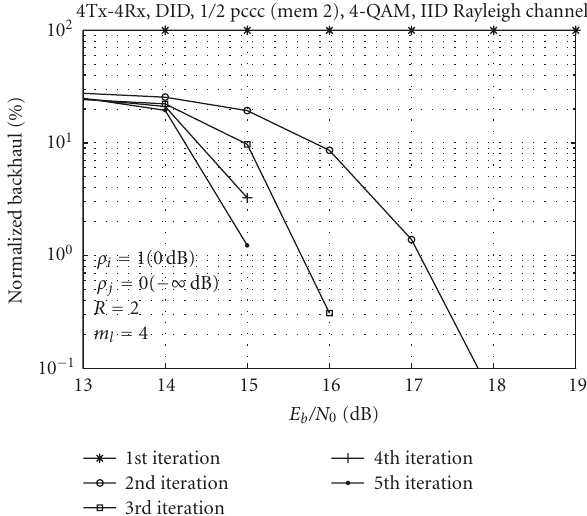
Figure 14: Backhaul tra ffi c normalized with respect to total infor- mation bits. Single-bit quantization of LLR values is performed. Only those bits that have changed signs between iterations are exchanged ( ρ i = 0dB).